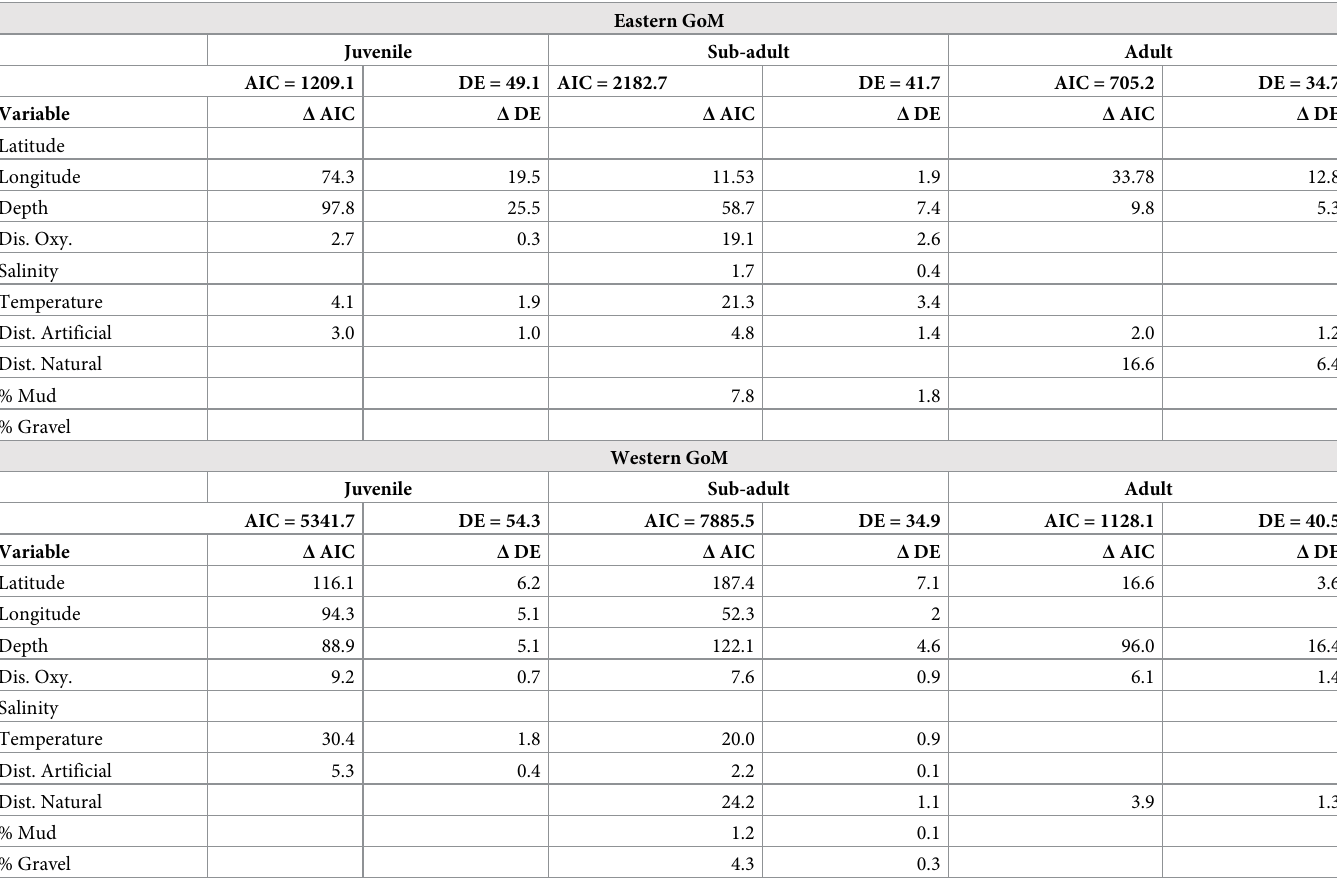
Table 1. Environmental variables retained in final generalized additive models for juvenile (age-0), sub-adult (age-1-2), and adult (age-2+) red snapper over uncon- solidated substrate of the eastern and western